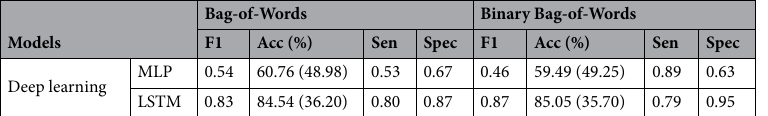
Table 10. Performance result obtained with deep learning LSTM and MLP applied to Bag-of-Words and Binary Bag-of-Words feature representation of the validation (peptide) data.